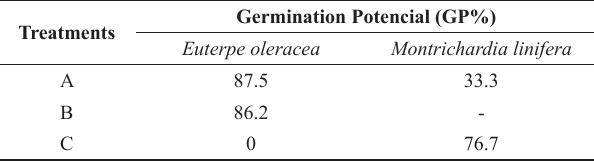
Tab. 2. Alimentary Index (AI